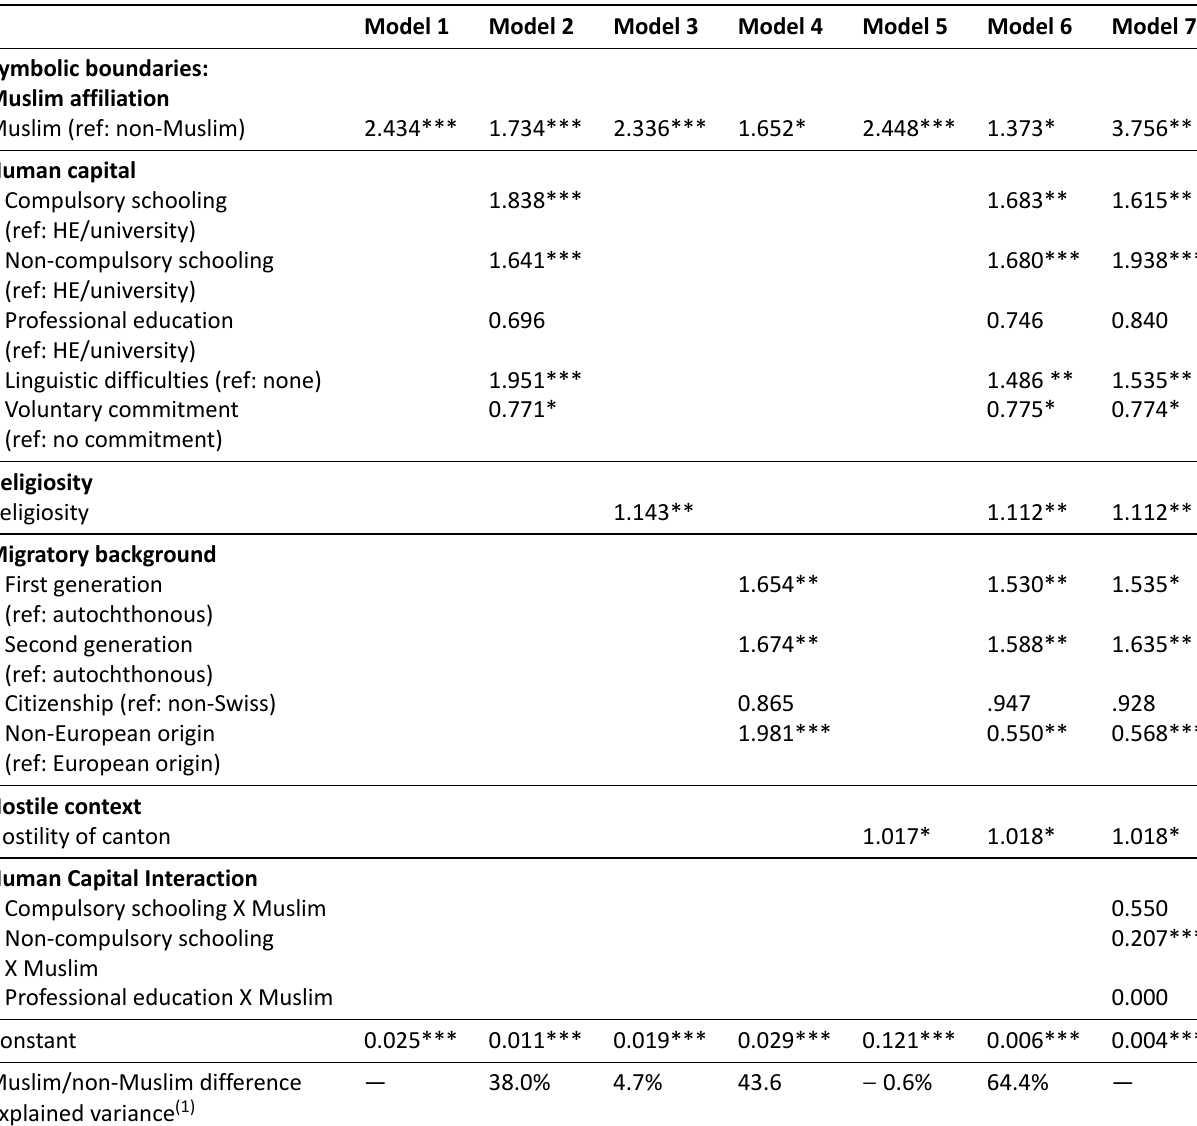
Table 2. Logistic regression with exp( 𝛽 ) coefficients predicting